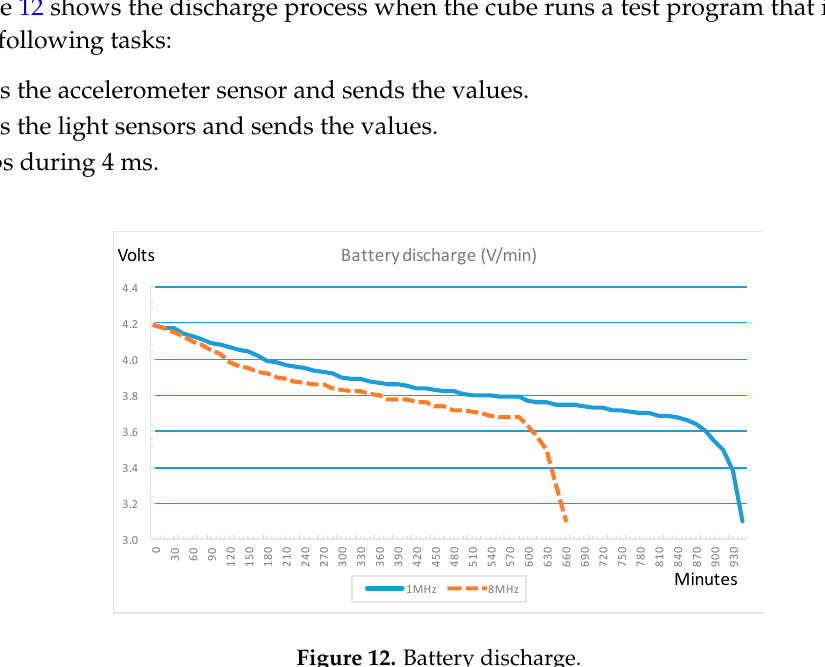
Figure 12. Battery discharge.